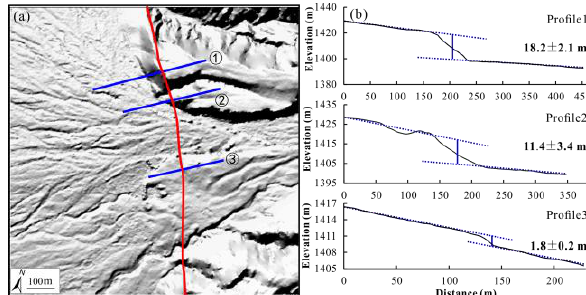
Figure 4. (a) Hill-shaded DEM of an area on the West Helanshan Fault, and the red line indicates the fault trace while the blue lines denote the selected topographic profiles.